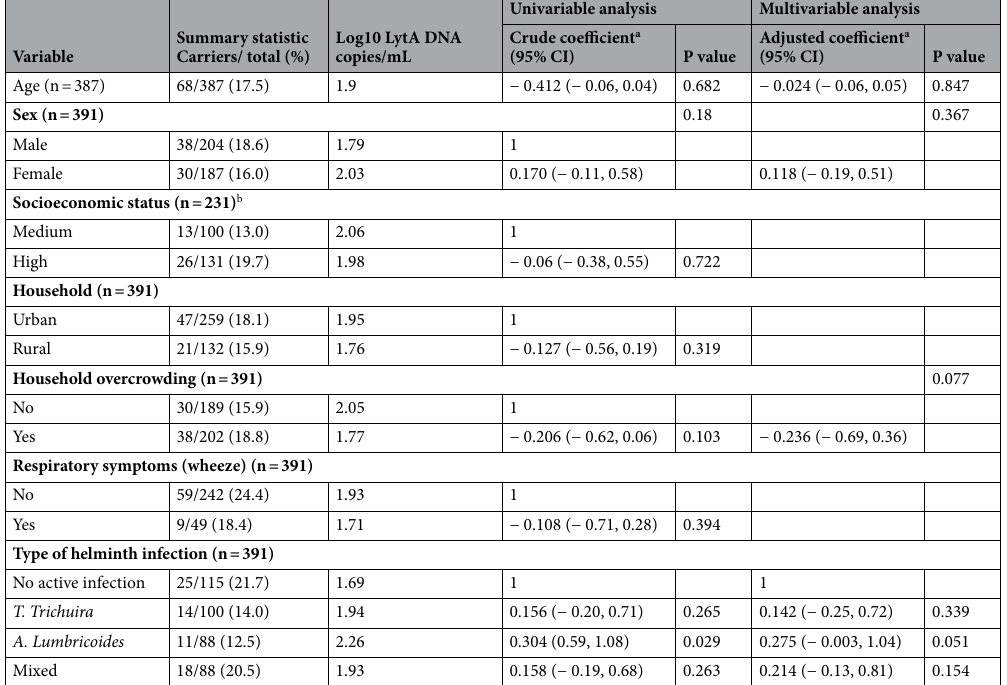
Table 1. Linear regression analysis of factors associated with S. pneumoniae density in children aged 54–95 months who are carriers. Analysis was restricted to positive carriers (no. of carriers/total for each category is indicated in summary statistic column) and results are reported as linear regression coefficients and 95% CI. All helminth infections alongside age and sex were then used in a multivariable regression model to estimate adjusted coefficients and identify independent associations. a Coeficient was log10 converted, e.g. those with A. lumbricoides infection have a pneumococcal density of 0.3 log10 higher than those with no active infection. b The first component that accounted for 30% of variation was divided into tertiles to represent low, middle and high socioeconomic status as described by Menzies et al . (2014) 22 . Median age for participants was 60 months, IQR = 1